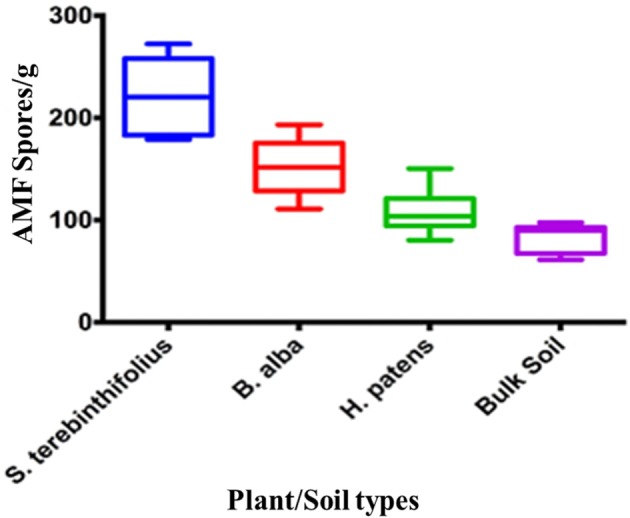
Numerical abundance of AMF spores extracted from S. terebinthifolius, H. patens, and B. alba rhizospheres and bulk soil in six south Florida locations.